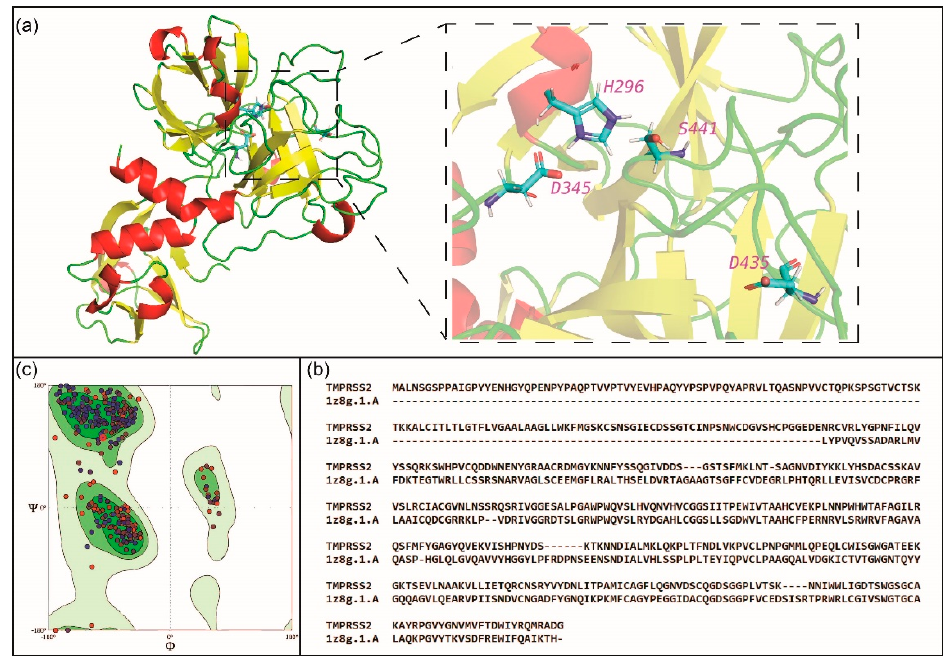
Figure 2. ( a ) Cartoon representation of the homology model structure of TMPRSS2 which has been energy-minimized using UCSF Chimera. The figure zooms into the region containing the catalytic triad Ser441 (S441), His296 (H296) and Asp345 (D345), and the substrate binding residue Asp435 (D435) in the S1 subsite of the enzyme. ( b ) Alignment of protein sequences for TMPRSS2 and hepsin (PDB 1Z8G) which was used as a template to model the structure of TMPRSS2. ( c ) General Ramachandran plot of the energy-minimized model structure of TMPRSS2, which displays the torsional angles, phi ( φ ) and psi ( ψ ), of the amino acid residues in the protein.